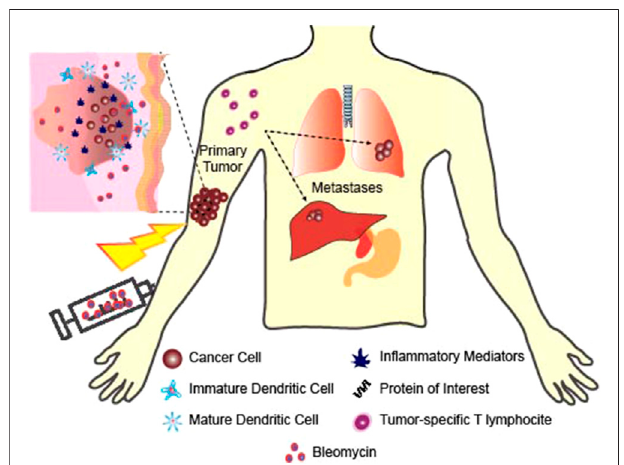
FIGURE 3 | Healing of non-targeted and contralateral tumor using ECT. ECTcreatestumorspeci fi cimmunecellsthathavetheabilitytokillcancercells including the non-ECT sensitive tumor cells and tumor cells far from the ECT treated